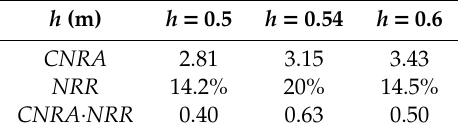
Table 4. Comparison among the results from model outputs with three weir heights ( h ).